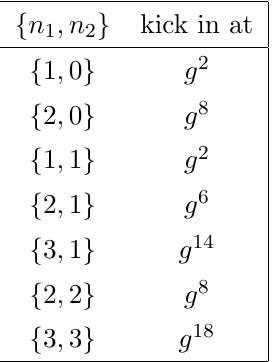
Table 1 . The order in g that a con(cid:12)guration of multi-mirror particles leaving in one edge or adjacent edges kicks in. More speci(cid:12)cally, consider the second graph of (cid:12)gure 2. The number n 1 ( n 2 ) correspond to the number of mirror particles in the edge denoted by z 1 ( z 2 ) in that (cid:12)gure. The power of g appearing in the table was computed by using the rule of (cid:12)gure 1. From the results in the table, we conclude that at two loop only the cases